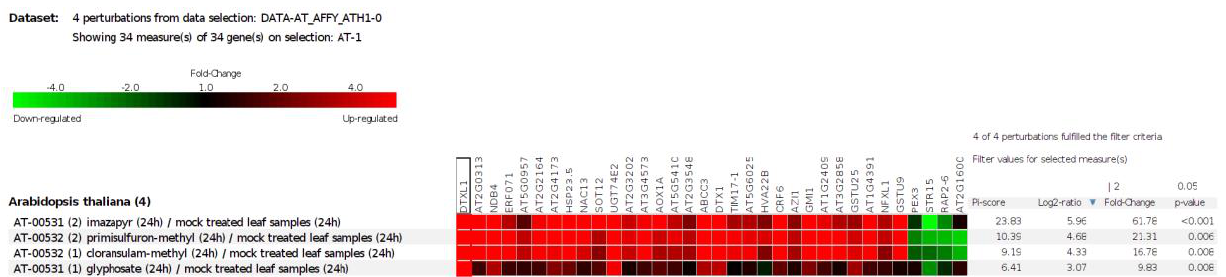
Figure 11. Common set of genes that were differentially expressed in the transcriptome of ailanthone-treated Col-0, Cvi-0, and U112-3 plants overlapping with the previously reported transcriptome profiles of herbicide-treated samples analyzed by using the Genevestigator database (accessed on 1 May 2021) (https://genevestigator.com/gv/).